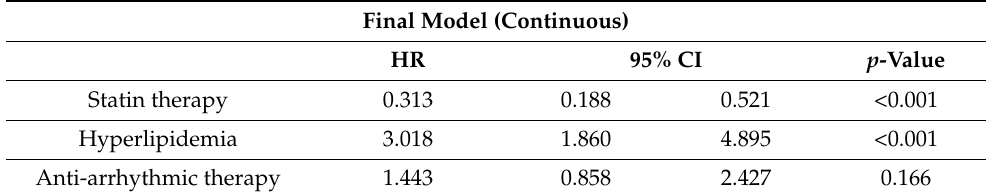
Figure 2. Cumulative incidence curve for recurrence of atrial fibrillation comparing patients with and without statins using propensity-matched pairs, with log-rank test. Table 3. Predictors of recurrent atrial fibrillation for the propensity-matched cohort using the augmented backward elimination